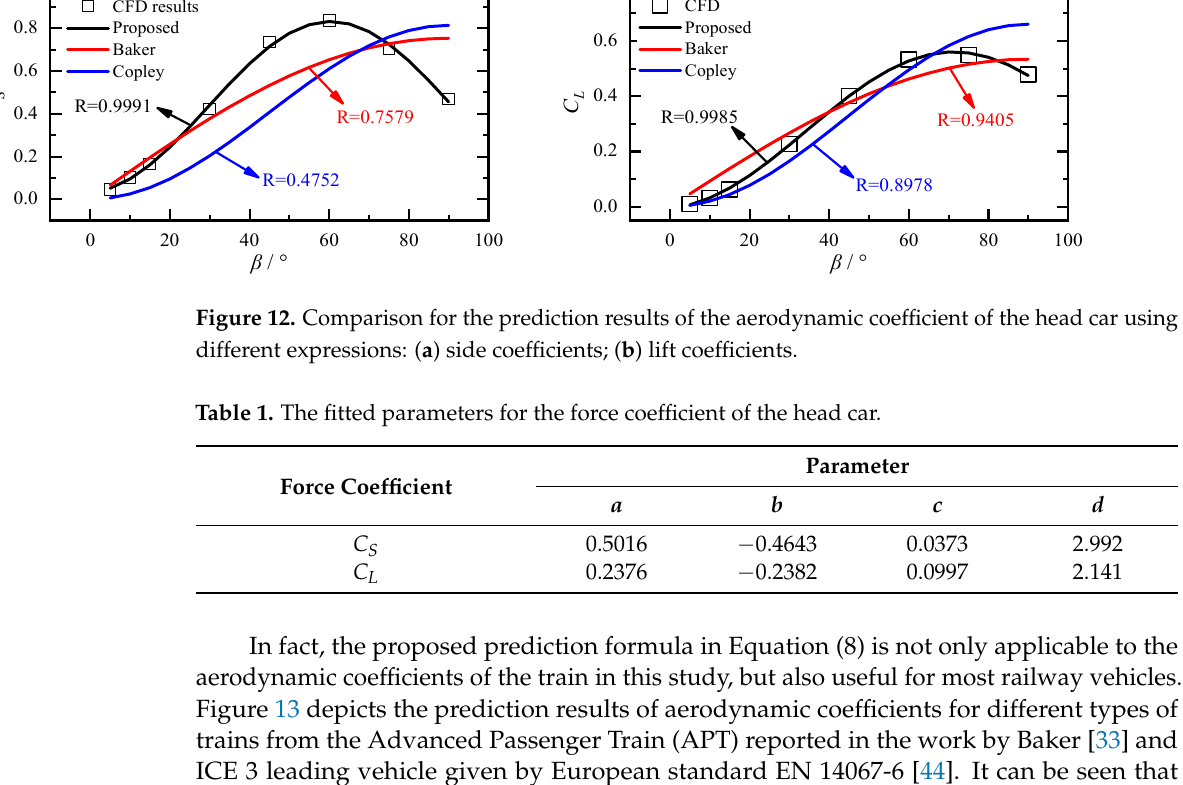
Figure 13. Prediction results of aerodynamic coefficients for different types of trains: ( a ) Advanced Passenger Train; ( b ) ICE 3 leading vehicle.